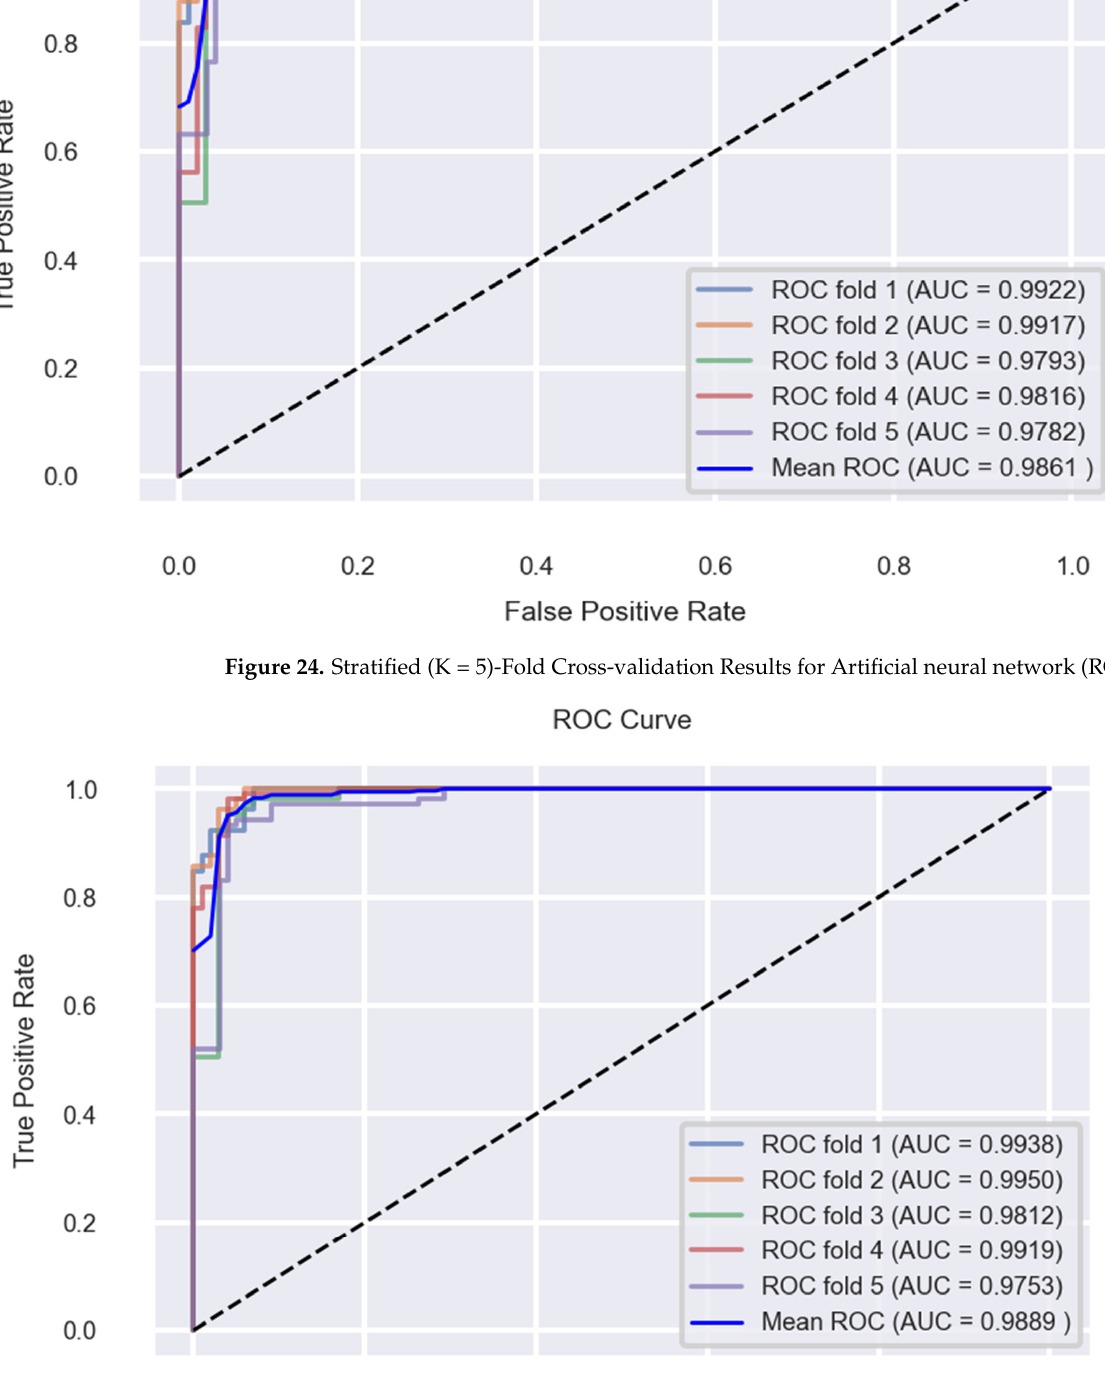
Figure 25. Stratified (K = 5)-Fold Cross-validation Results for Quadratic Discriminant Analysis (ROC-AUC).